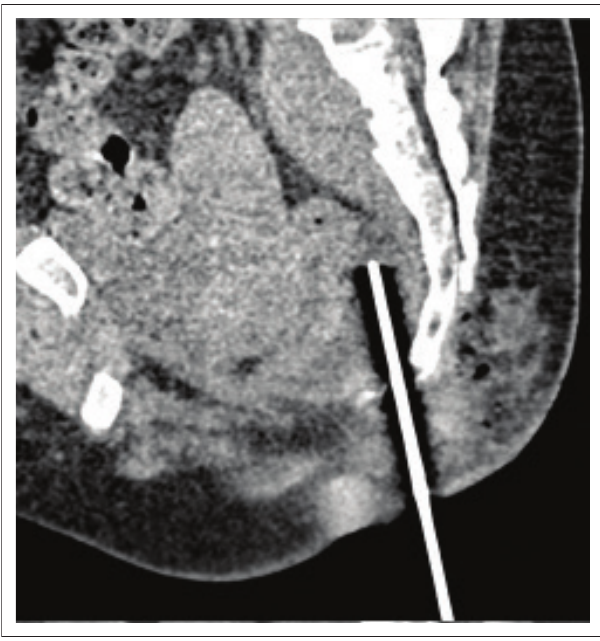
FIGURE 4: Sagittal image showing the progressive cranial advancement of the needle in the presacral space, made possible by anterior displacement of the rectum through repeated hydro-dissection. The needle is approximating the caudal extent of the collection.